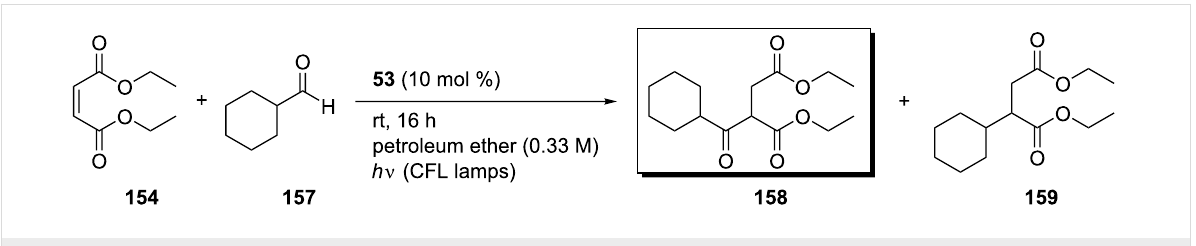
Scheme 37: Selectivity for the formation of the α , α -disubstituted